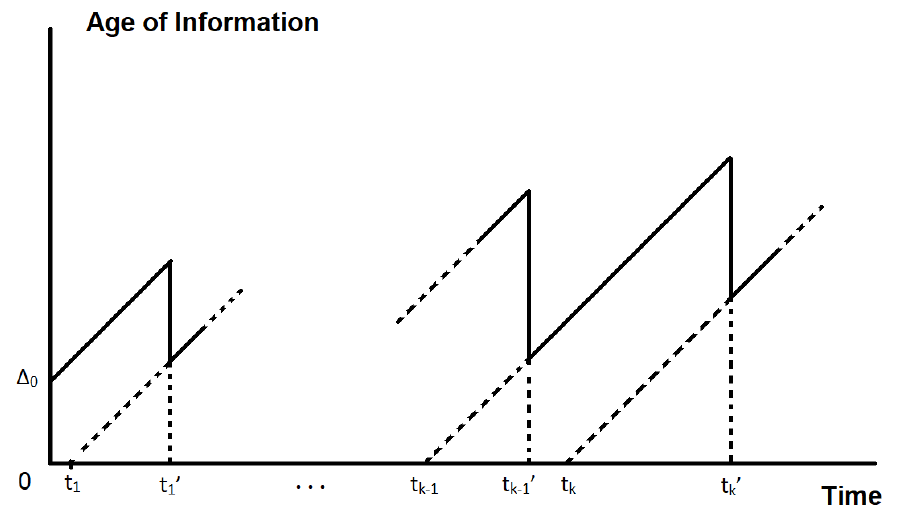
Figure 2. An indicative sample path of the process ∆ ( t ) showing how AoI grows and drops upon receipt of an update. This would be the AoI measured by a node for packets from a specific source. Multiple such samples would be obtained at the same node for packets belonging to other flows from different sources (or the same